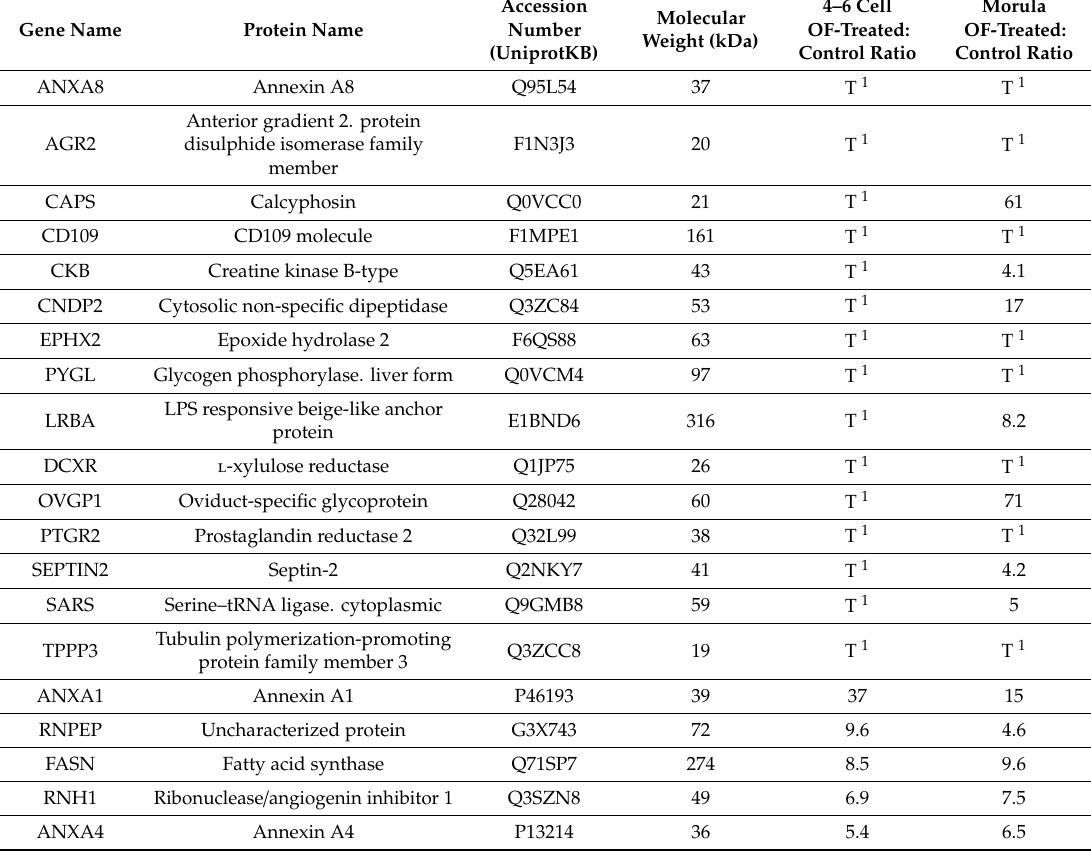
Table 3. Proteins identified as interacting with both the 4–6 cell and morula